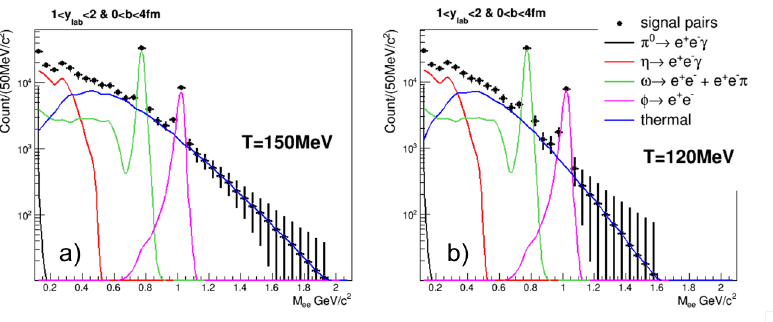
Figure 5. Expected invariant mass spectra of electron positron pairs for radiation temperature of 150 Mev (a) and 120 MeV (b)